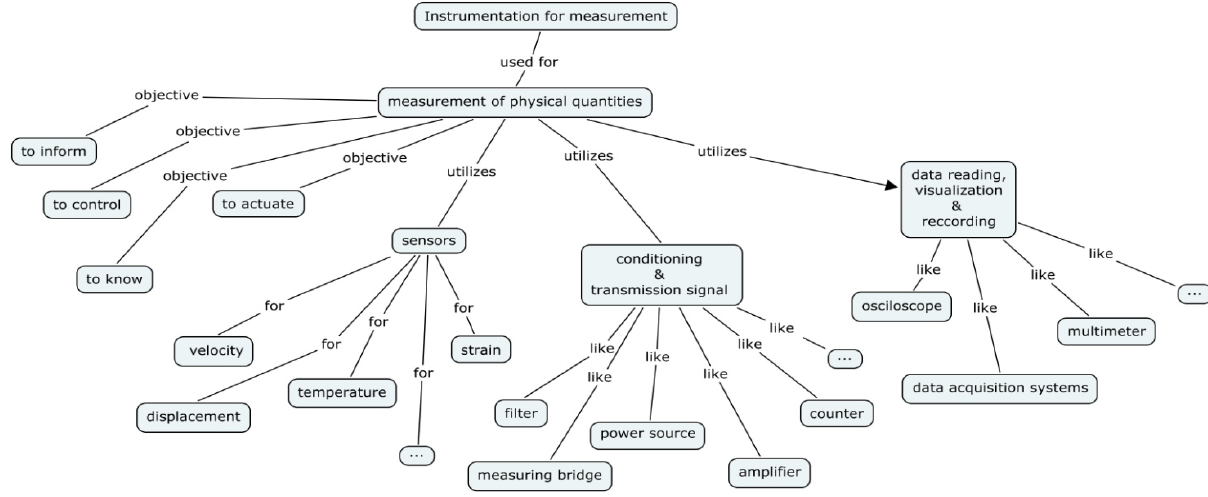
Figure 2. Concept Map Created with Student Input (Theoretical Lecture)